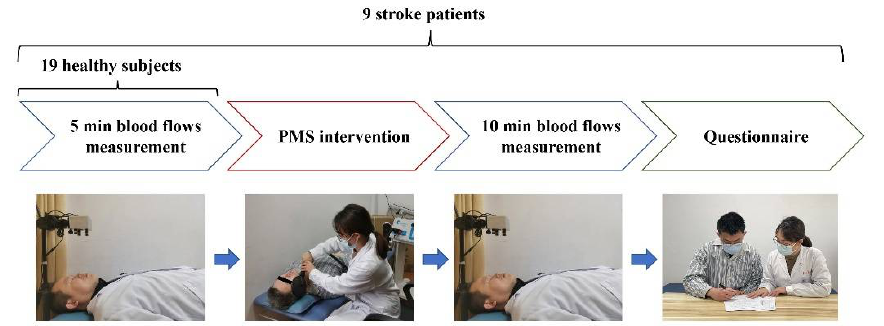
Figure 1. Experimental setup and intervention protocol. (The written informed consents from the individuals for the publication of the images were submitted as Supplementary Materials).